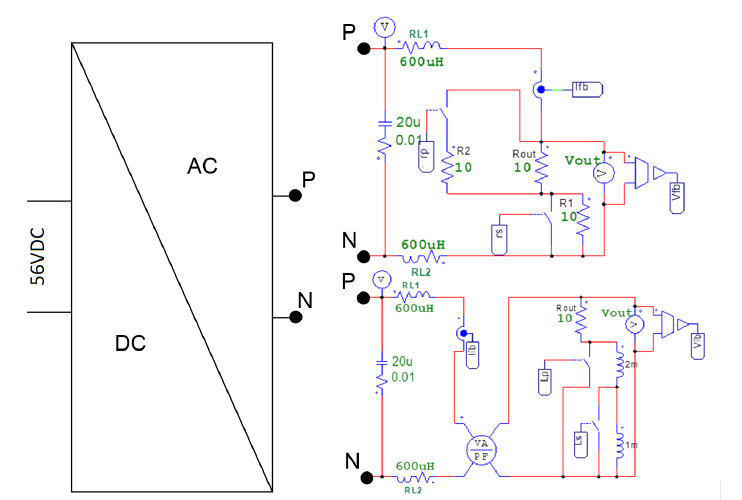
Figure 10. Simulation circuit modified for testing half and double resistive load and inductive load cases.